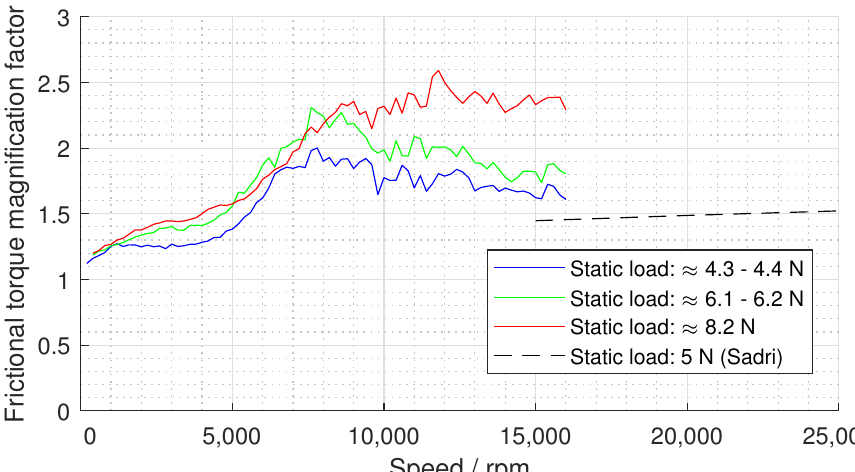
Figure 12. Calculated friction torque magnification factor between the two bearings from Figure 9 and from the results of Sadri